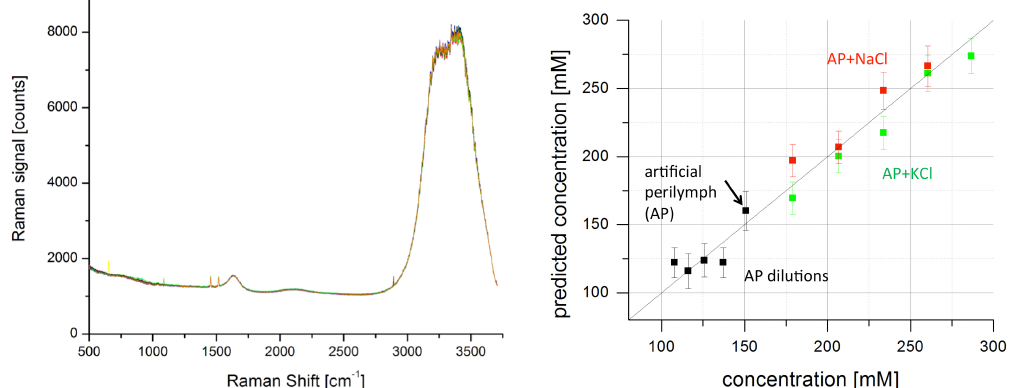
Figure 6. Raman spectra of samples of artificial perilymph that was either diluted or spiked with NaCl or KCl ( left ) and prediction of the small ion concentration by multivariate analysis based on the Raman spectra ( right